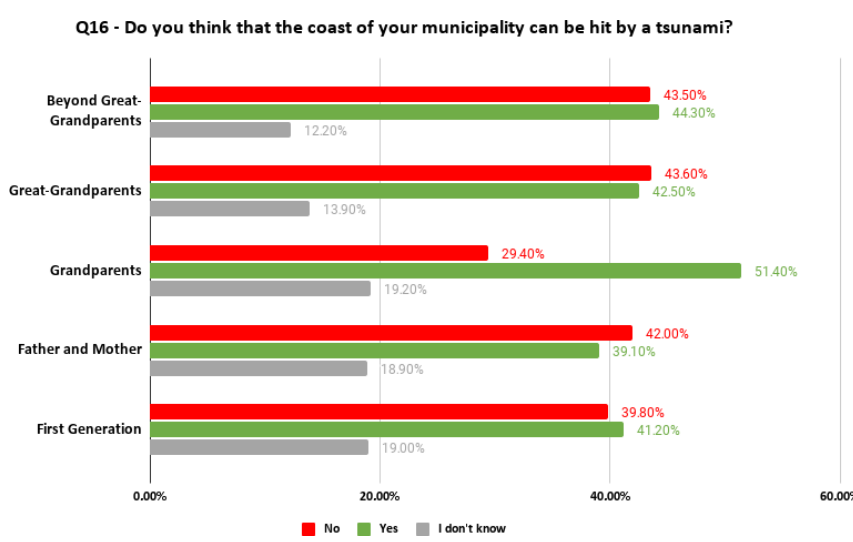
Figure 5. Q16 – tsunami risk perception in municipalities according to the numbers of generations of residence in the area.